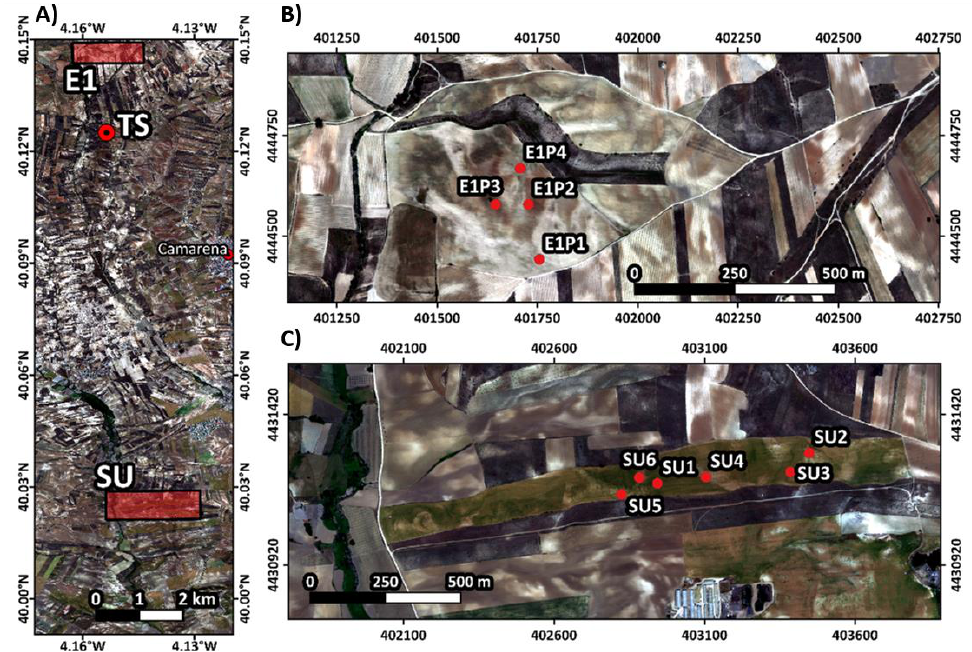
Figure 5. CASI true-color RGB (R: 0.64 µm G: 0.55 µm B: 0.44 µm) mosaic of the area of study with ( A ) location of the crop fields of interest, ( B ) zoom on the E1 area, ( C ) zoom on the SU area. Red dots and labels indicate location of field plots.